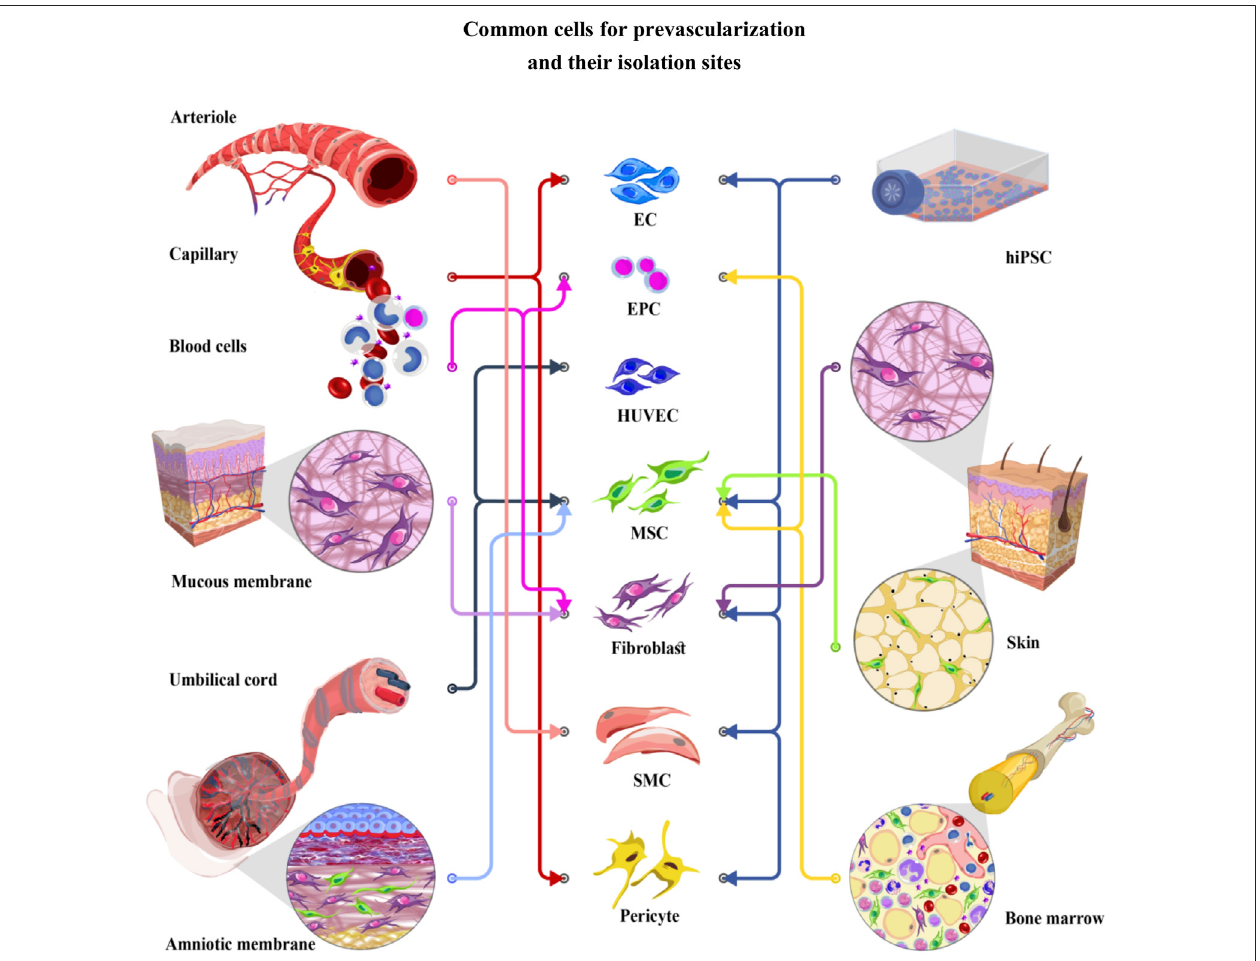
FIGURE 1 | Common cells for prevascularization and their isolation sites. EC (Endothelial cells), EPC (Endothelial progenitor cells), HUVEC (Human umbilical vein endothelial cells), MSC (Mesenchymal stem cells), fi broblast, SMC (Smooth muscle cells), and pericyte have been used for prevascularization of different tissues. Endothelialandsupportingcellscanbeobtainedfromvariouscellsources,includingskin,mucosalmembrane,bone,andperipheralblood,ordifferentiatedfromhiPSCs (human induced pluripotent stem cells). Recently, particular attention has been given to the umbilical cord and amniotic membrane as easy to access cell sources. These cells show lower immunogenicity than the other cell lineages, introducing them as excellent candidates in the prevascularization process.